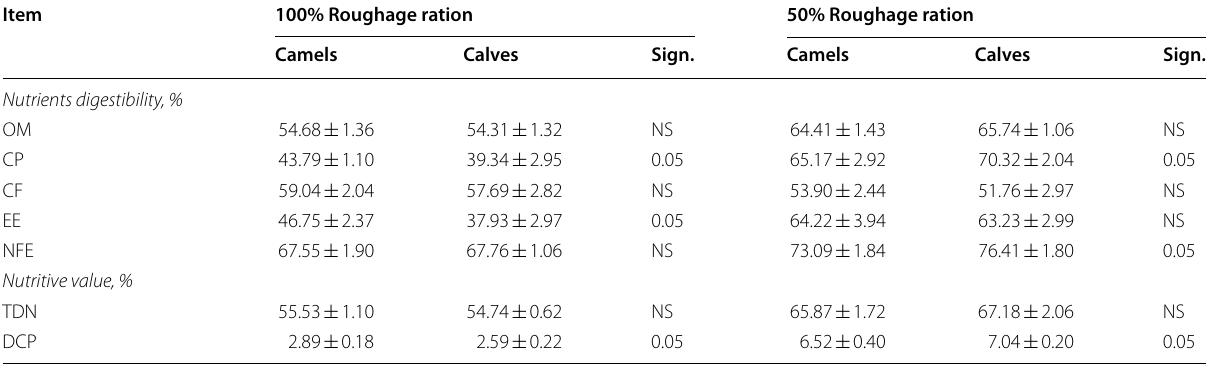
Table 3 Nutrients digestibility and nutritive value (%) of 100% and 50% roughage rations by camels and cow calves (means